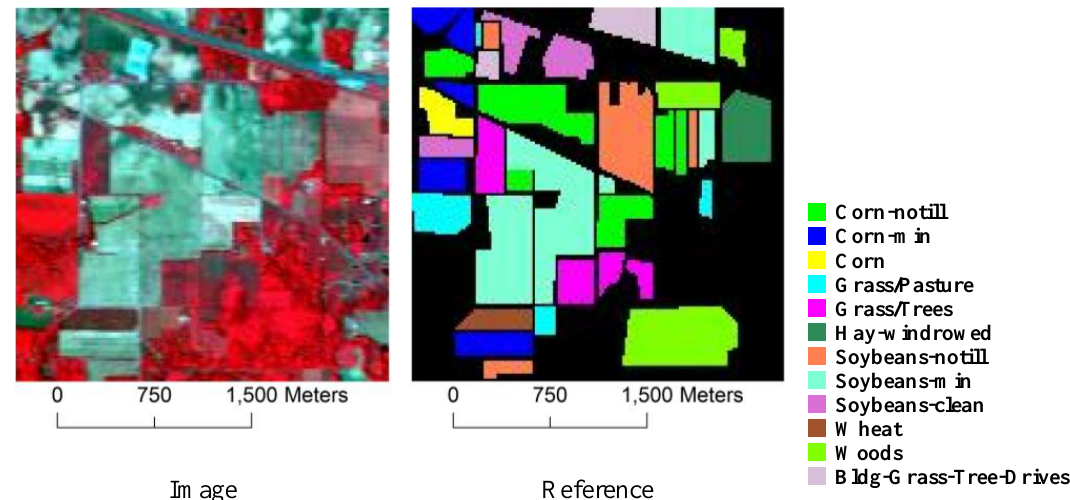
Figure 3. The Indian Pines image and its reference